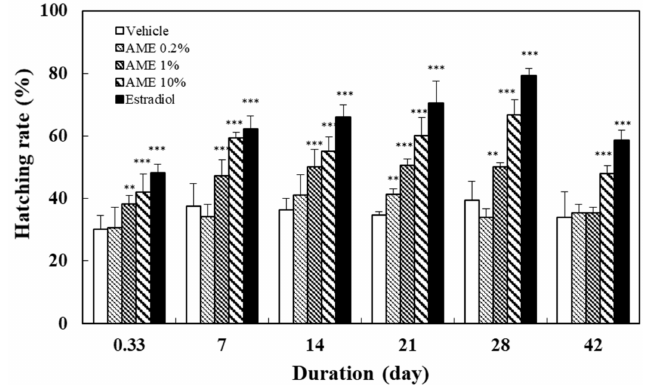
Figure 3. Effects of the supplementation with AME on the hatching rate of the fertilized eggs. Each dataset is represented by five independent repeated experiments. Statistical differences compared to the vehicle group were tested using one-way ANOVA. Levels of significance are expressed as ** p < 0.01 and *** p <